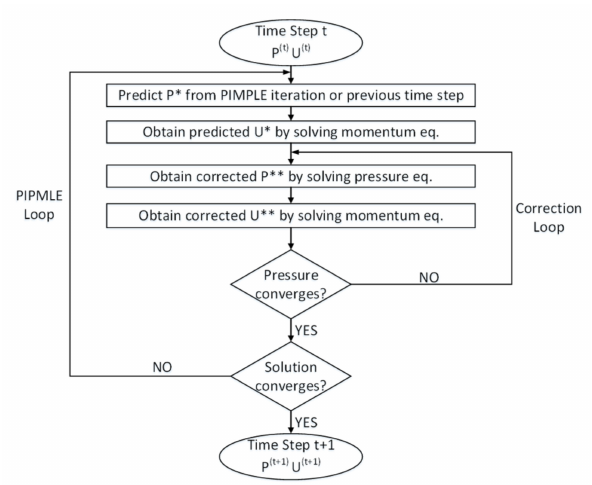
Figure 3. Flowchart of the PIMPLE algorithm; * and ** correspond to predicted and corrected fields,